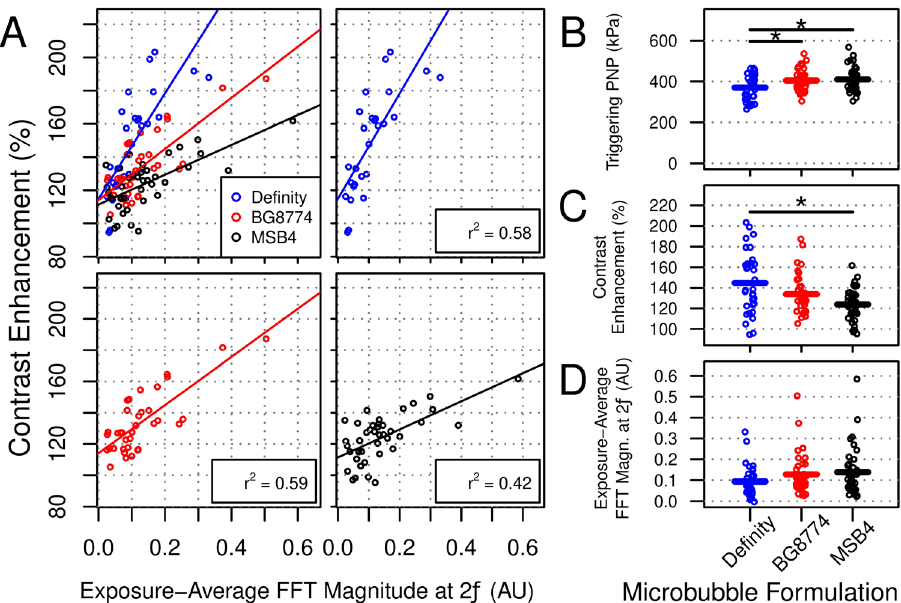
Figure 4. Acoustic feedback control algorithm testing. The peak negative pressures (PNPs) of sonications for animals in cohort #2 were calibrated based on the detection of ultraharmonic emissions. ( A ) Relative gadolinium contrast enhancement from contrast-enhanced T1-weighted imaging post-sonication is plotted in relation to exposure-average magnitude of 2 f emissions for each microbubble formulation. Positive linear correlations were observed for all groups, with adjusted r 2 values of 0.58, 0.59, and 0.42, for Definity, BG8774, and MSB4, respectively. Pairwise analyses indicated that each microbubble formulation displayed a significantly different relationship compared to the other two formulations. ( B ) The mean triggering PNPs (i.e. PNP required to detect ultraharmonic emissions) were 370 kPa ± 60 kPa, 405 kPa ± 51 kPa, and 410 kPa ± 59 kPa, for Definity, BG8774, and MSB4, respectively. Significant differences were detected between Definity and both BG8774 (p = 0.03) and MSB4 (p = 0.01). ( C ) Mean relative gadolinium contrast enhancement approximately 10 min following sonication was significantly greater at targets sonicated with Definity in circulation than MSB4 (p < 0.001). ( D ) No significant differences were detected in mean exposure-average magnitude of second harmonic emissions between microbubble formulations. AU arbitrary units, FFT fast Fourier